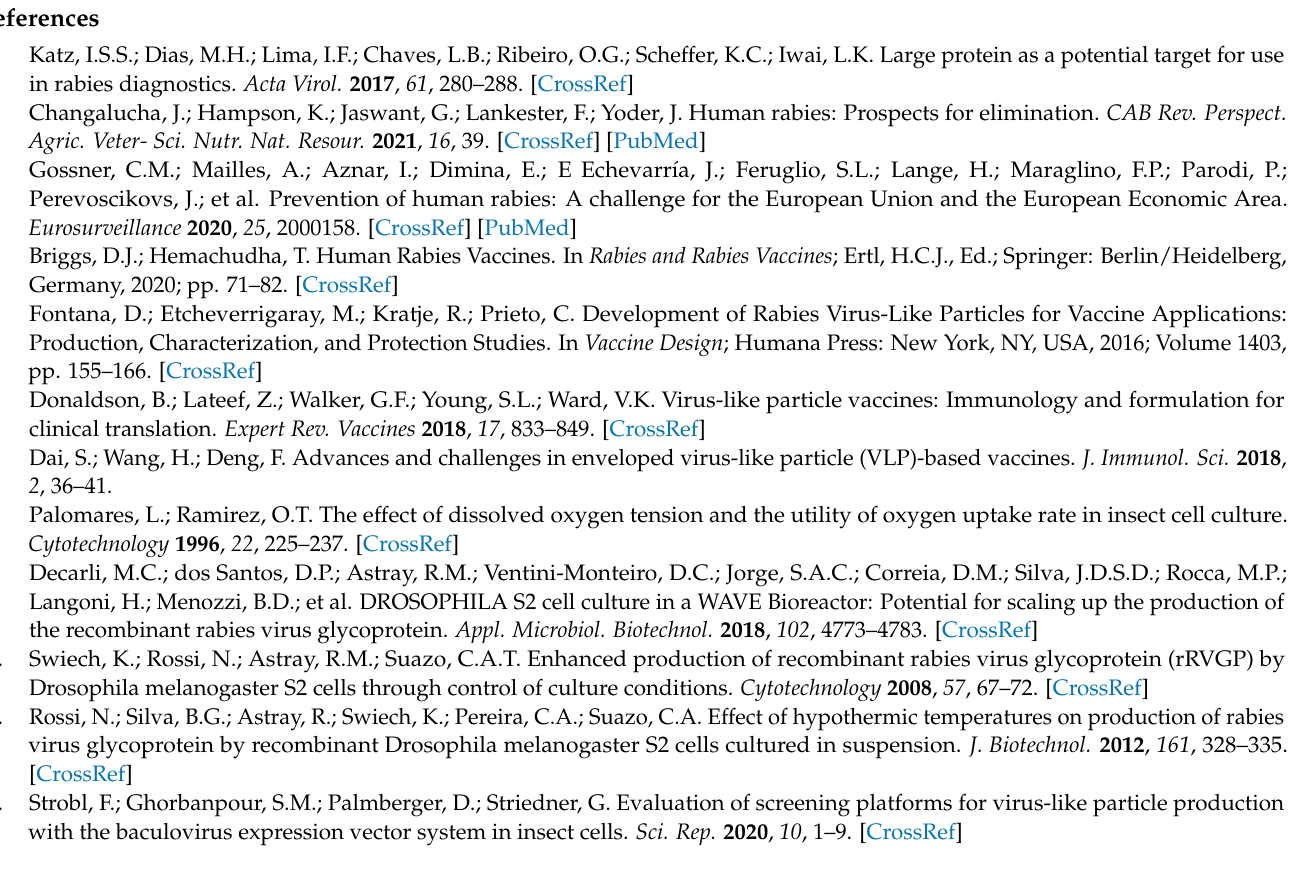
matrix protein (BVM) with a ratio between BVG and BVM of 2.0 using Schott flask as culture system. Figure S14: Kinetics profiles of rabies G glycoprotein (RVGP) production (measured by ELISA) from Sf9 cells co-infected with recombinant baculoviruses carrying the rabies glycoprotein (BVG) and matrix protein (BVM) with a ratio between BVG and BVM of 2.5 using Schott flask as culture system. Figure S15: Perturbation graph of BVM MOI (A), BVG/BVM MOI ratio (B), and HT (C) on rabies G glycoprotein concentration (RVGP) (determined by ELISA) modelled